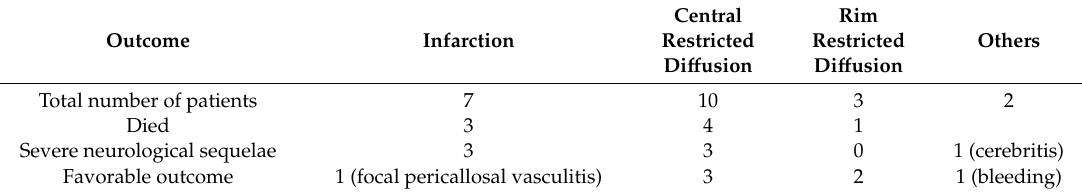
Table 2. DWI and ADC findings and